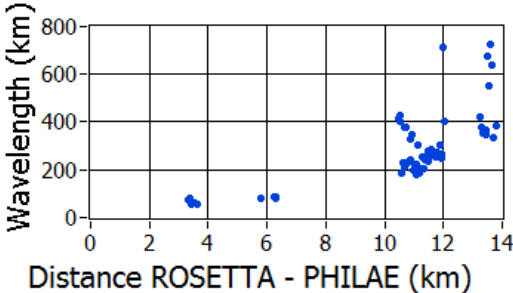
Figure 13. The estimated wavelengths, projected on the orbiter- lander connecting line, are plotted versus the orbiter-lander dis-